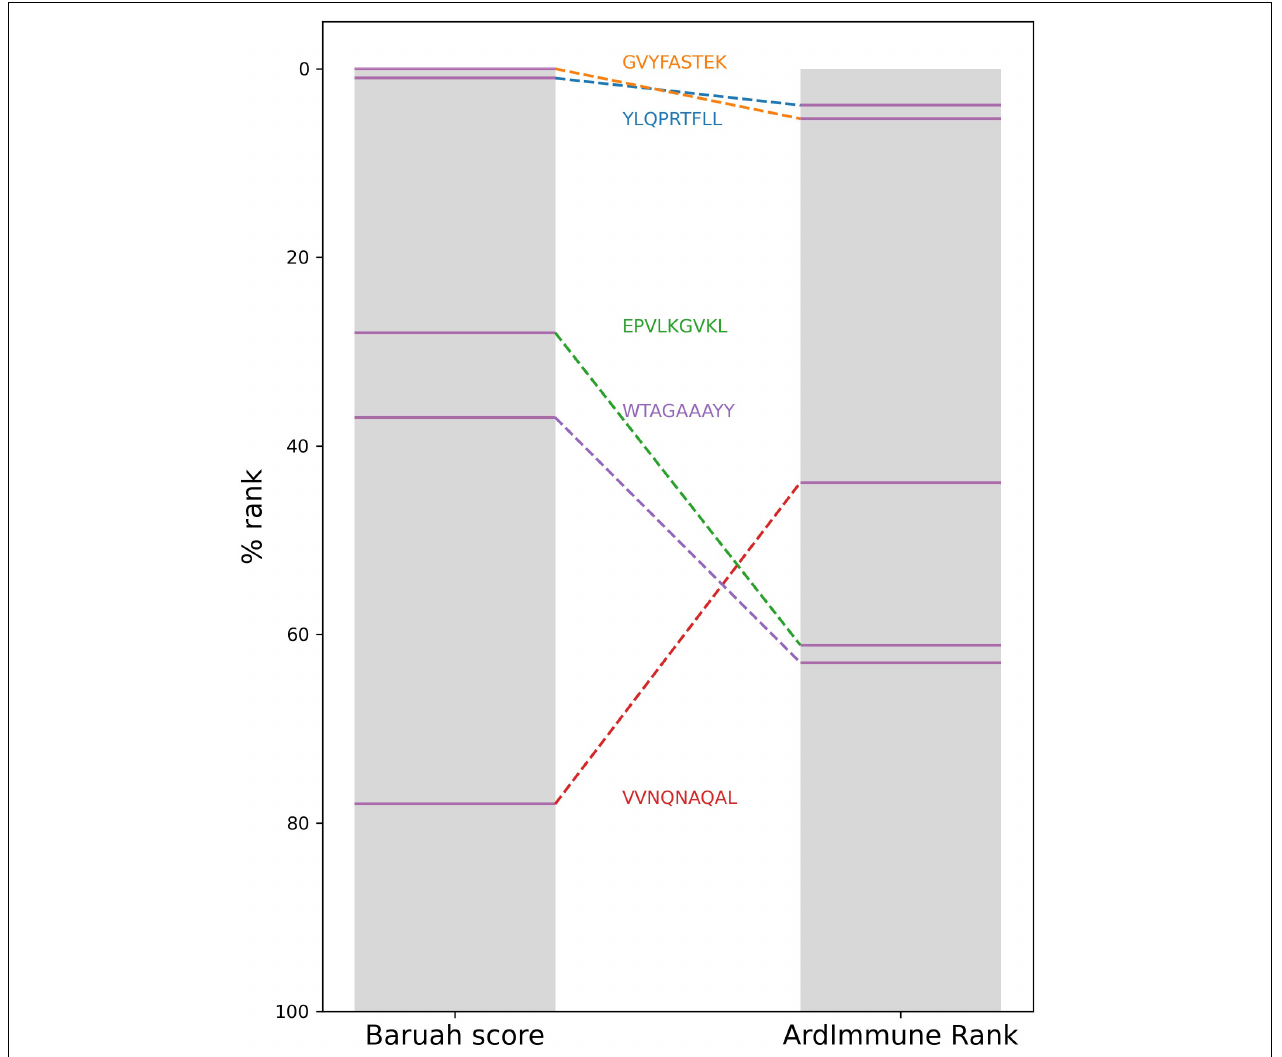
FIGURE 8 | The HLA percentile ranks of the five peptides selected by Baruah et al. as computed from Baruah score and ArdImmune Rank.